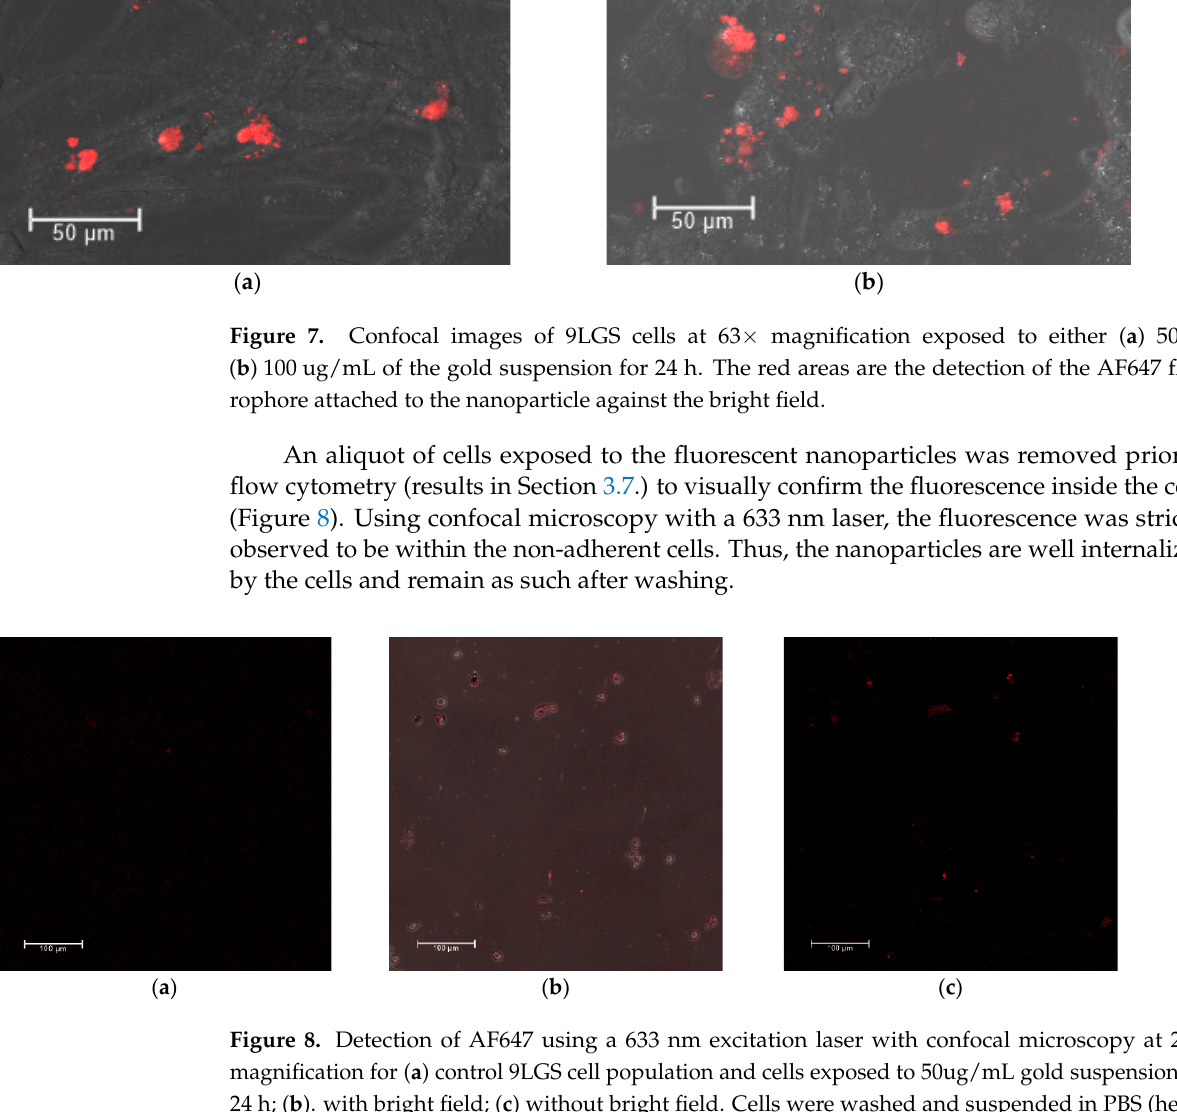
( b ) Figure 9. Forward scatter vs. side scatter for ( a ) control cell population and ( b ) cells exposed to 50 μ g/mL AuNP suspension for 24 h. Forward vs. side scatter is commonly used to identify the size of cells and particulates. If nanoparticles were large or aggregated and internalized, the side scatters would increase dramatically.